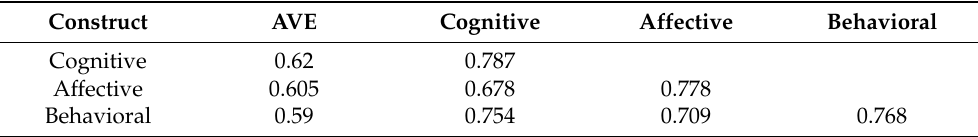
Table 8. The results of the confirmatory factor